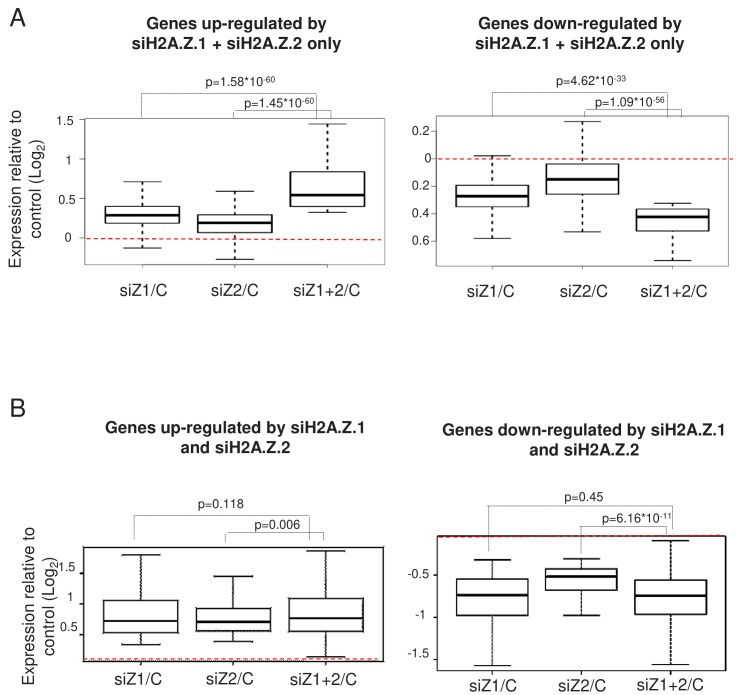
Effect of the double depletion of H2A.Z.1 and H2A.Z.2 on genes similarly regulated by H2A.Z.1 and H2A.Z.2.(A) For genes up-regulated (left) or down-regulated only after the combined depletion of H2A.Z.1 and H2A.Z.2, we calculated the ratio between its expression in either H2A.Z.1-depleted cell, H2A.Z.2-depleted cells, or cells depleted for H2A.Z.1 and H2A.Z.2 together versus control cells. Boxplots show the median, the 25% percentiles and the extrema within the gene population of the Log2 of this ratio (without outliers). The p value shows the significance of the difference between the two populations (paired welch test). (B) Same as in A for genes up-regulated (left) or down-regulated (right) after the depletion of H2A.Z.1 and H2A.Z.2 alone.